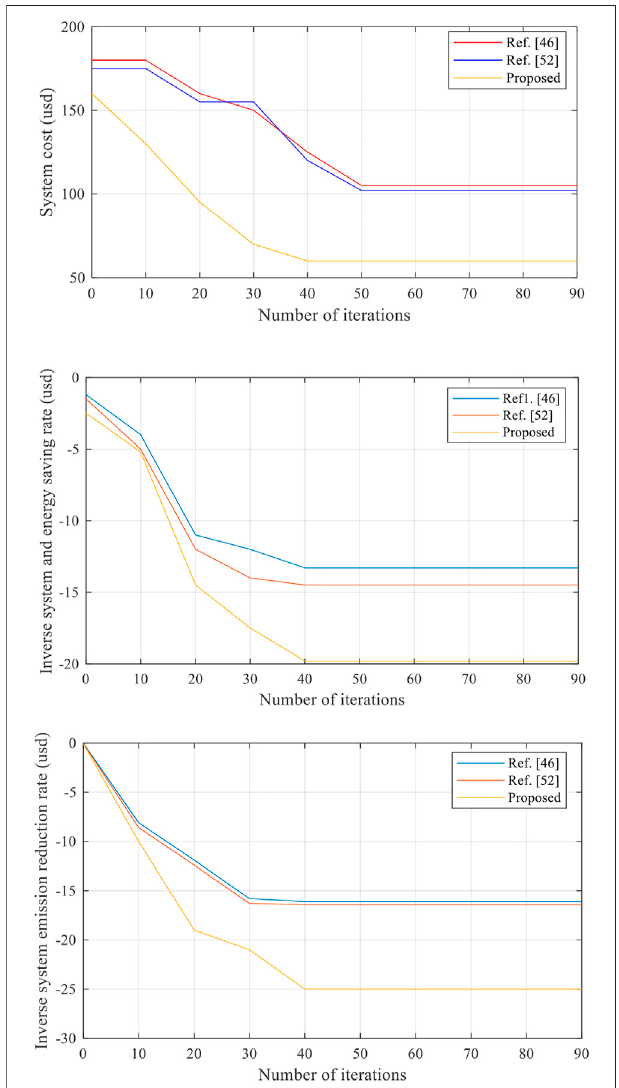
FIGURE 15 | Comparison of the proposed algorithm with references (Eshraghi et al., 2019; Liu et al., 2020) algorithms for a different number of